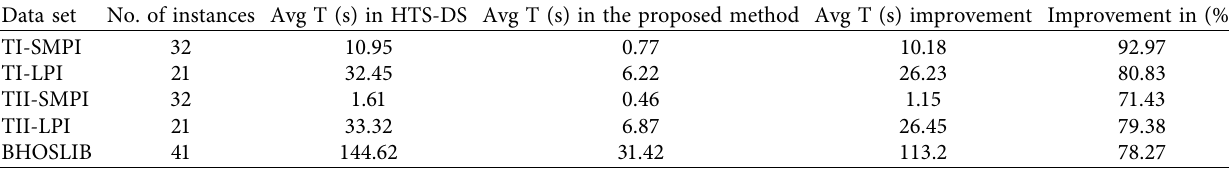
Table 11: Comparison in average time improvement for datasets.